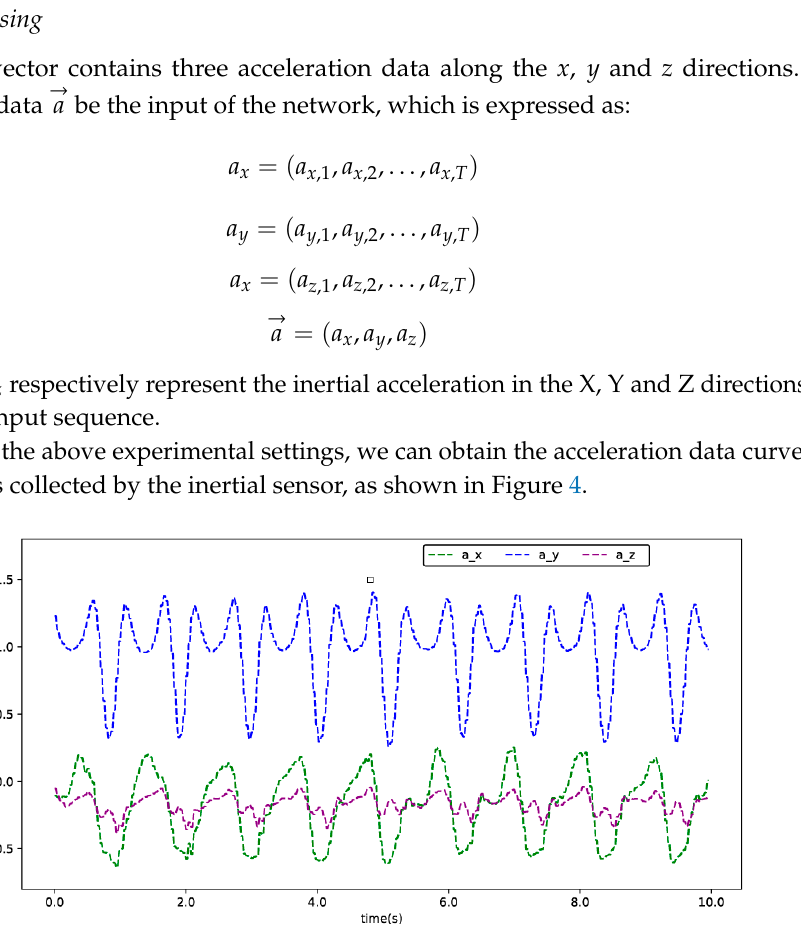
Figure 4. Acceleration data collected under the calf. a_x, a_y and a_z represent the acceleration data in the X -axis, Y -axis and Z -axis directions collected by the experimental equipment, respectively.